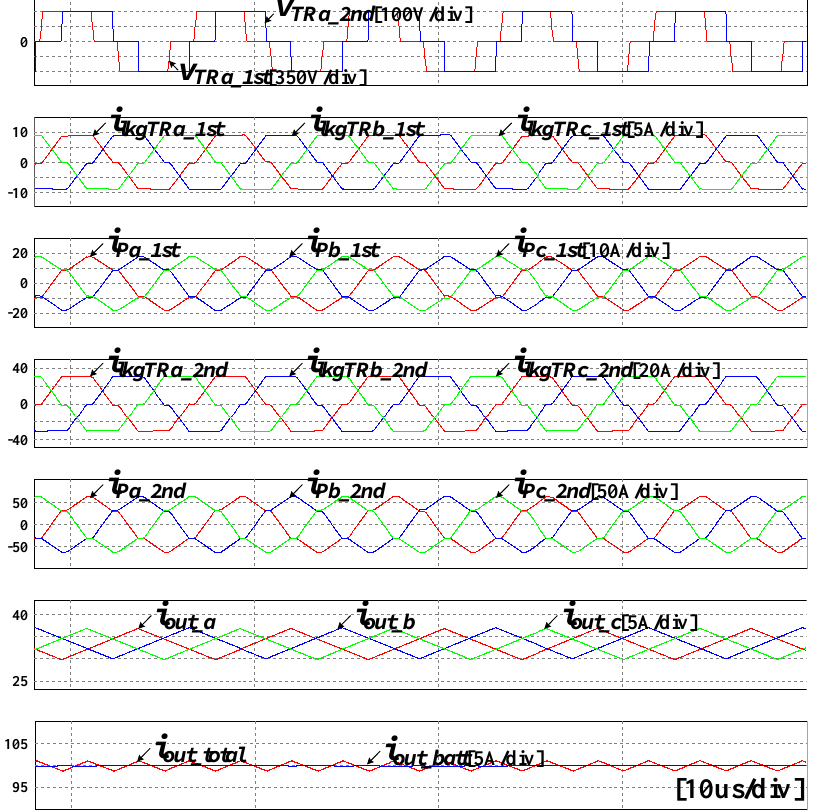
Figure 12. Key waveforms of the 3P-CFDAB converter.